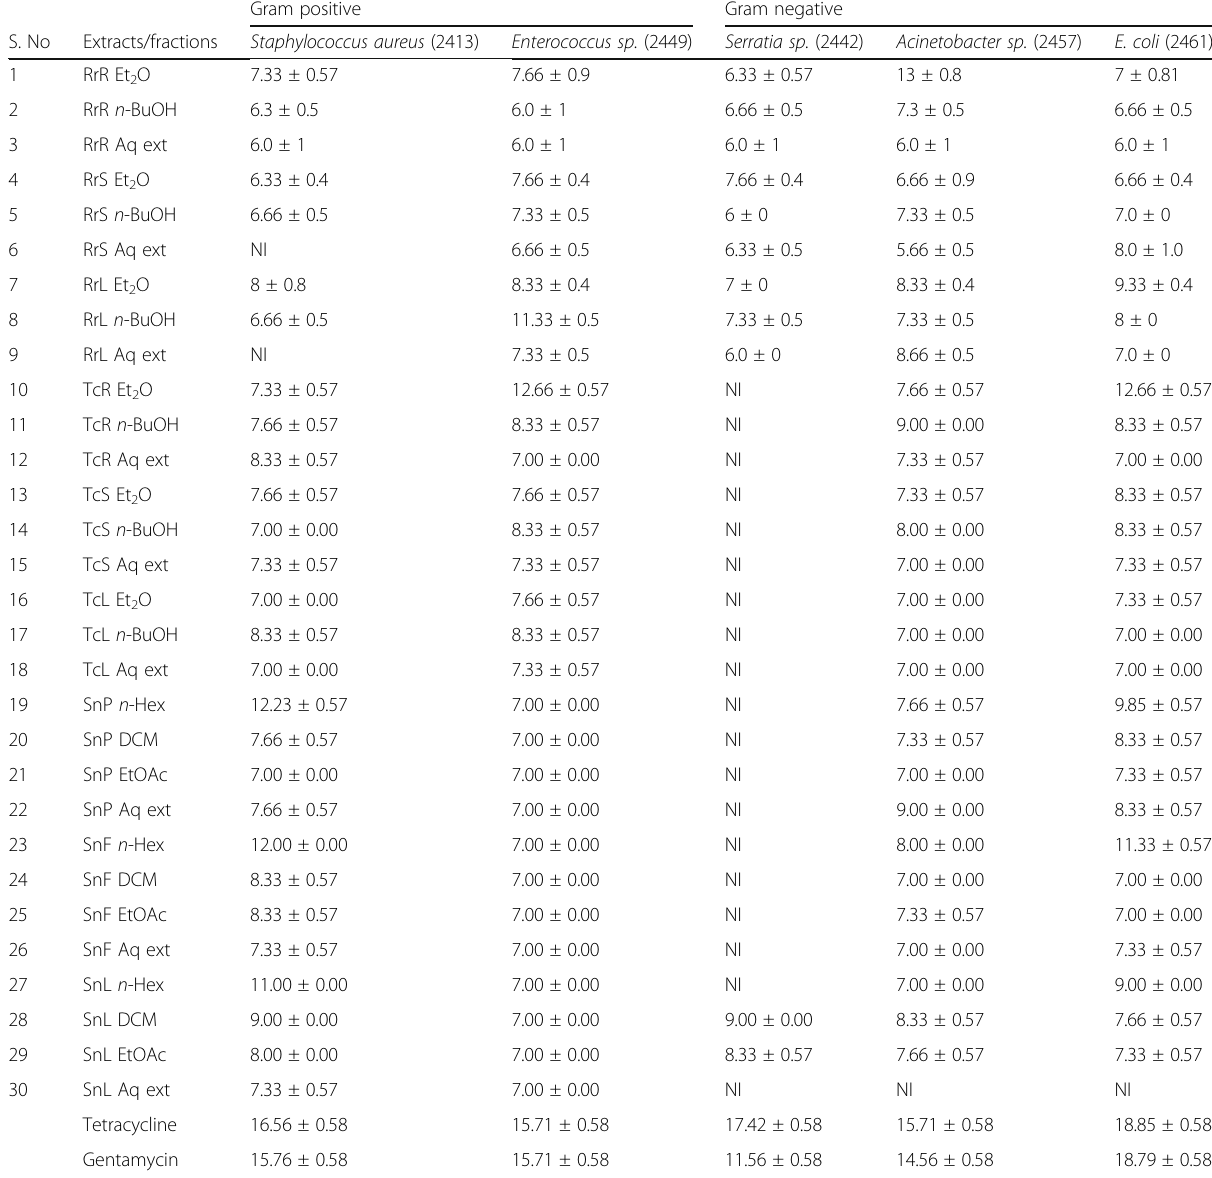
Table 7 Antibacterial activity of various extracts/fractions of orchids by agar-well diffusion method Gram positive Gram negative S. No Extracts/fractions Staphylococcus aureus